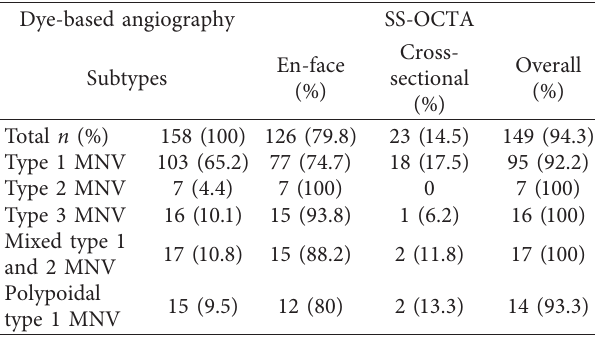
Table 2: The diagnostic sensitivity of SS-OCTA compared to MNV subtypes as classified by dye-based